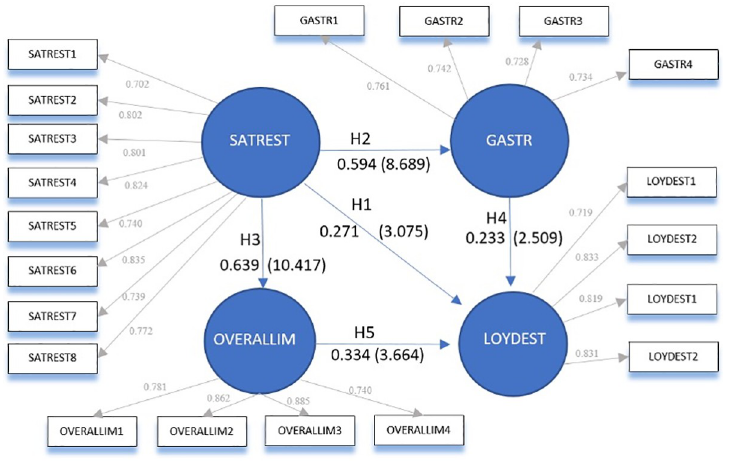
Fig 2. Casual relationships of the model. Source: